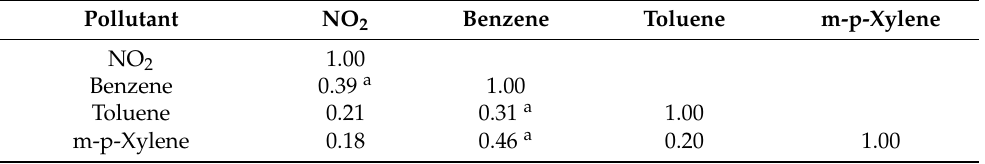
Table 4. Correlation coefficients between ambient NO 2 and BTX compounds.